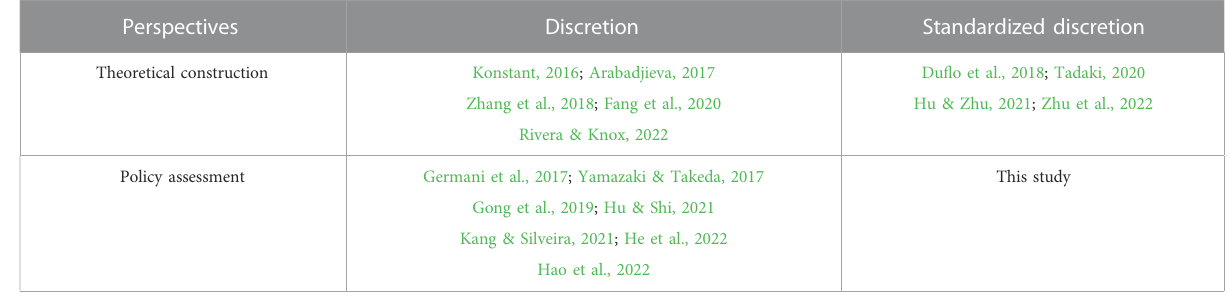
TABLE 4 Studies on discretion and standardized discretion.